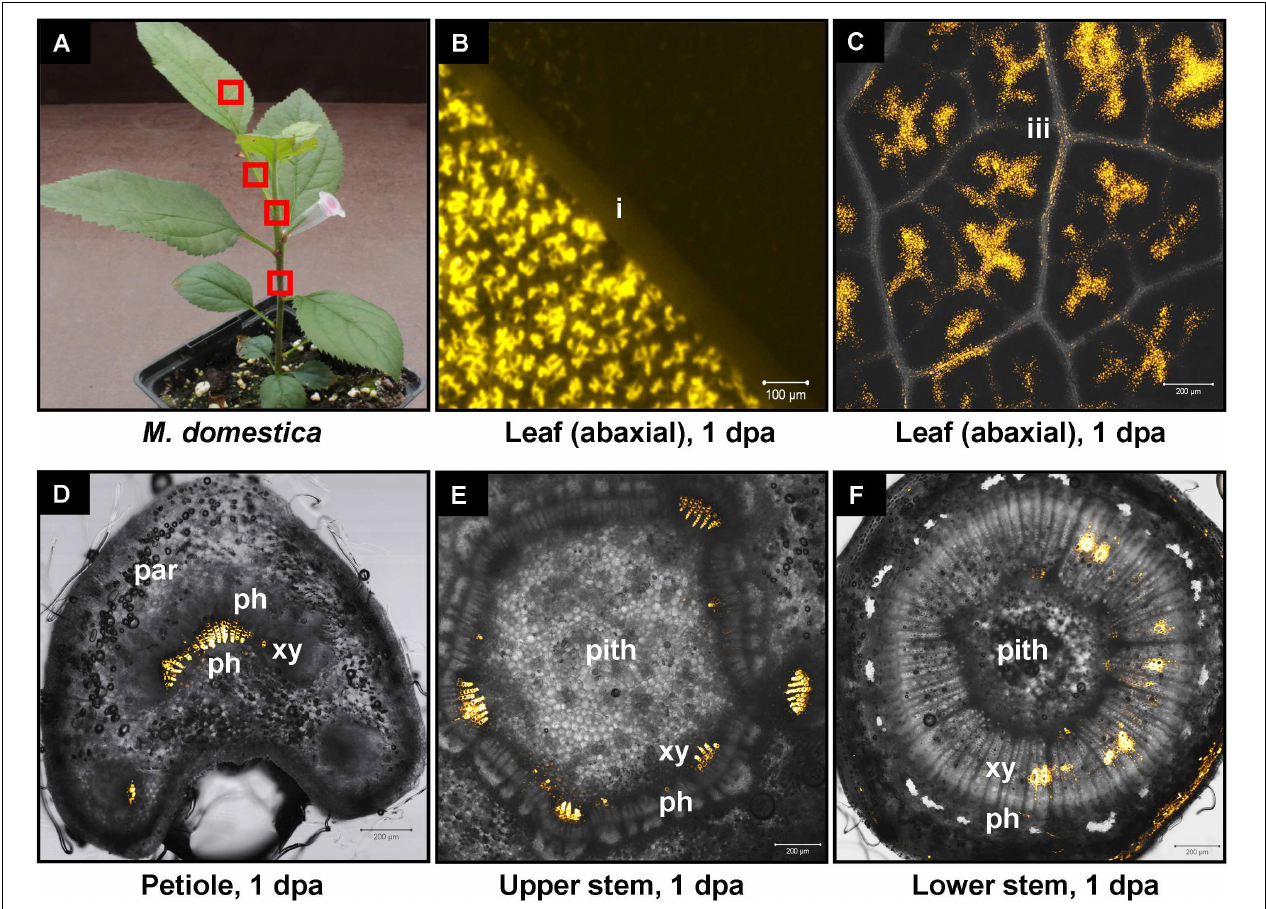
FIGURE 6 | Delivery of CY3-labeled 22-nt siRNA by petiole absorption to young apple tree. (A) Red boxes indicate parts of the plant that were subjected to microscopy 1 dpa. (B) Fluorescence microscopy of the abaxial side of a distant leaf. (C) Confocal microscopy of the abaxial side of a leaf. (D) Confocal microscopy of the petiole (cross section) of a leaf. (E) Confocal microscopy of the stem (cross section) above the site of CY3-labeled siRNA application. (F) Confocal microscopy of the stem (cross section) below the site of CY3-labeled siRNA application. Abbreviations: i, class I vein; iii, class III vein; st, stomata; xy, xylem; ph, phloem; par, parenchymatic